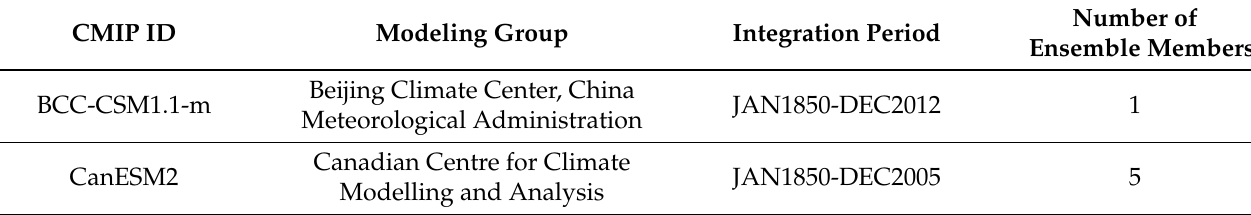
Table 2. Details of the CMIP5